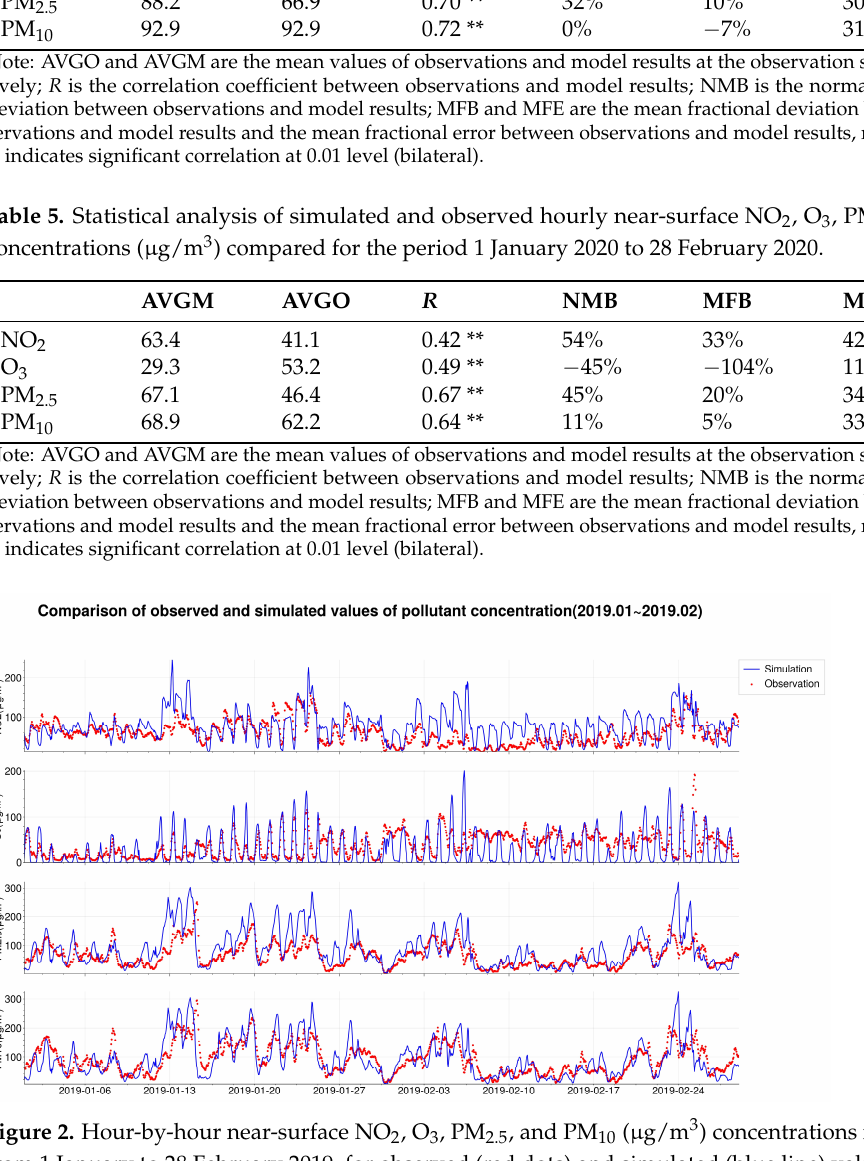
Table 5. Statistical analysis of simulated and observed hourly near-surface NO 2 , O 3 , PM 2.5 , PM 10 con-